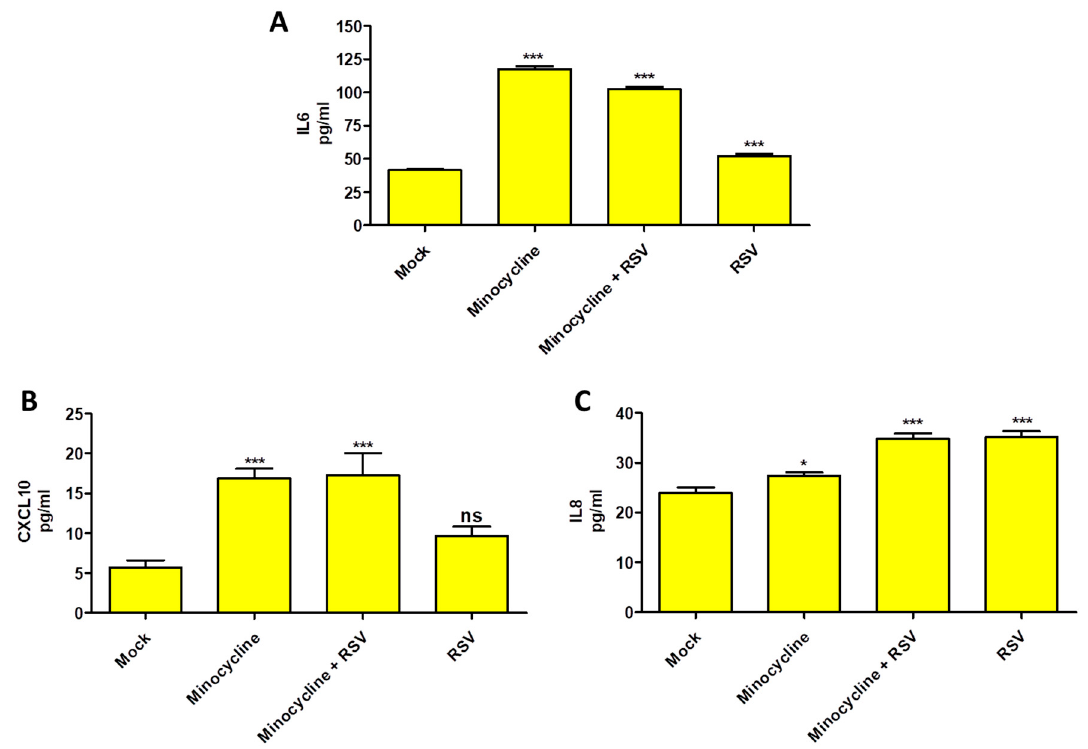
Figure 3. Cytokine production at 24 h in minocycline, minocycline + RSV and RSV treatment groups compared to mock control by ELISA ( A ) IL-6, ( B ) CXCL10, ( C ) IL8. n = 3, values in the graphs represent mean with standard deviation (as error bar) with One-way ANOVA, Tukey’s multiple comparison test, significance level * p ≤ 0.05 or ** p ≤ 0.01 or *** p ≤ 0.0001 or ns as non-significant.